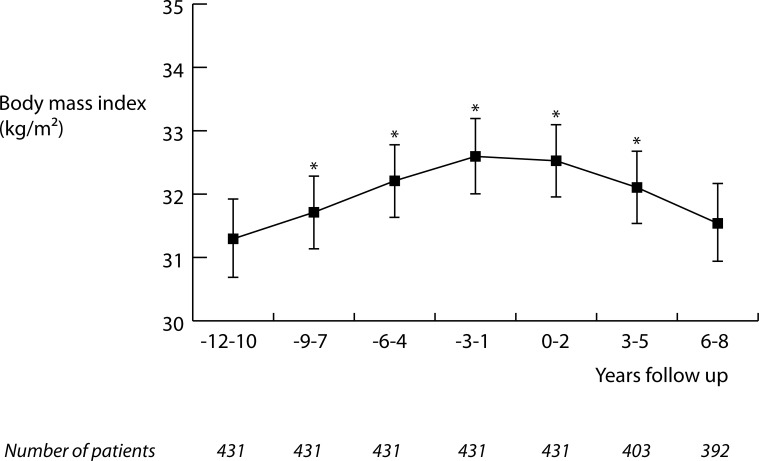
Body mass index course using estimated means in patient with type 2 diabetes included in DIALECT-1, during a retrospective follow-up period of 12 years and a prospective follow-up period of 8 years.Estimated means were calculated using linear mixed model analysis. The brackets represent 95% confidence interval of the mean. * Significant estimated mean change from starting BMI (P<0.05).